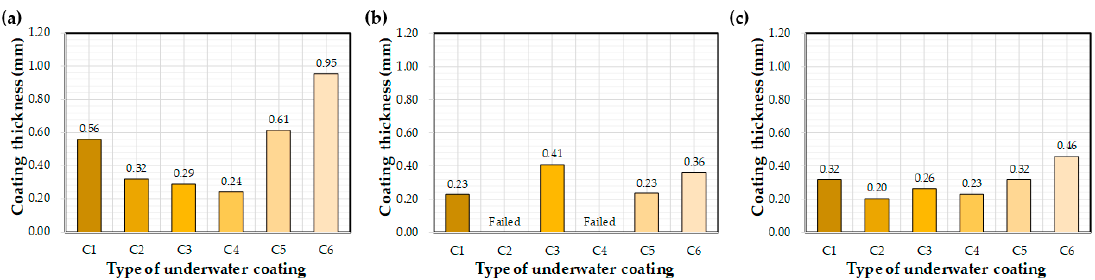
Figure 6. Average coating thickness after 72 h of water exposure: ( a ) control, ( b ) E1, and ( c ) E2.